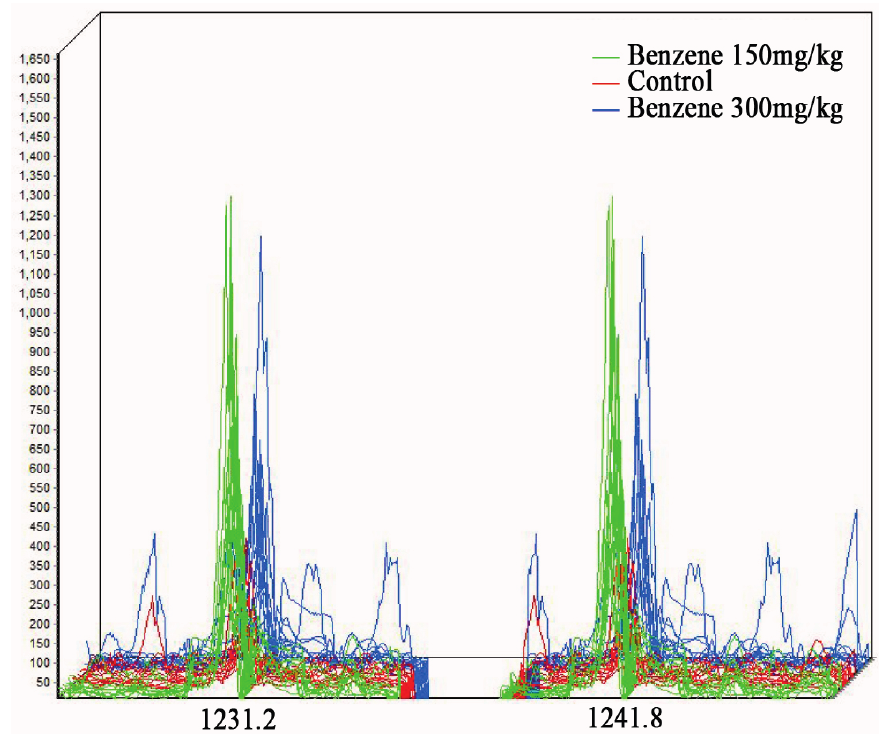
Figure 2. Three-dimensional m/z ratio-intensity maps showing significantly different protein spectra between the three groups. Peptides with molecular weights (MWs) of 1231.2 Da and 1241.8 Da were the two that differed most significantly between control and exposure groups. Green curve, benzene 150 mg/kg; red curve, control group; blue curve, benzene 300